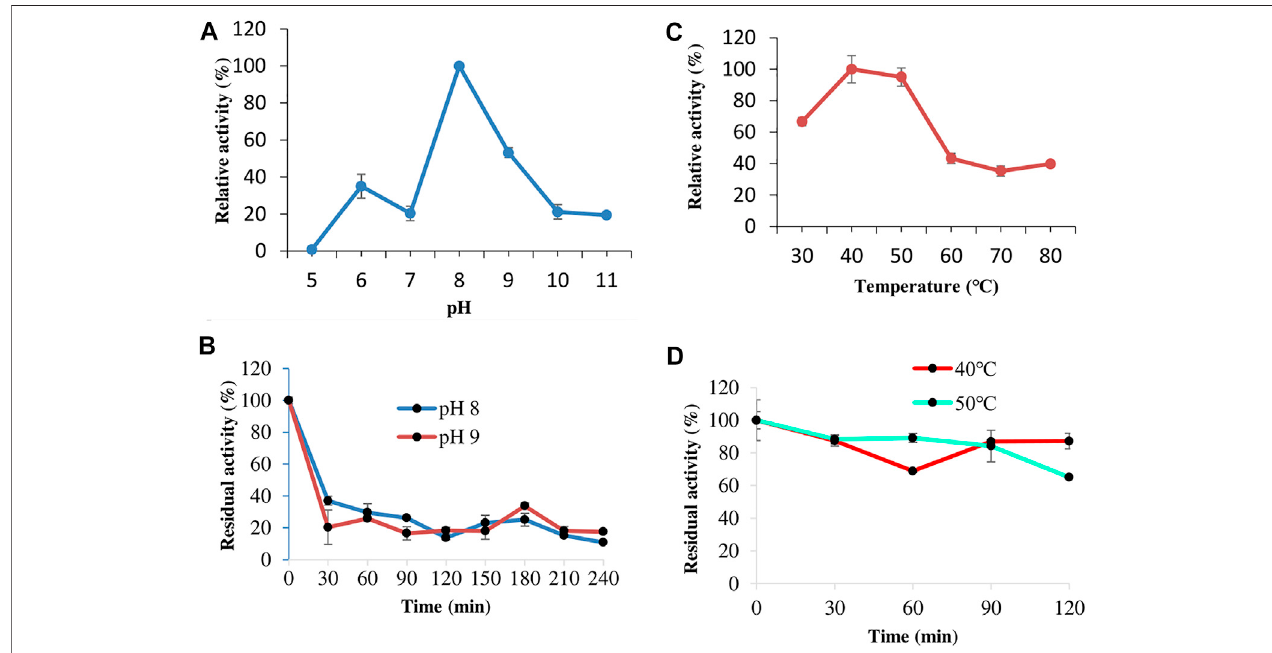
FIGURE 3 | The effect of pH on keratinase activity (A) and stability (B) . The study of keratinase thermoactivity (C) and thermostability (D) .